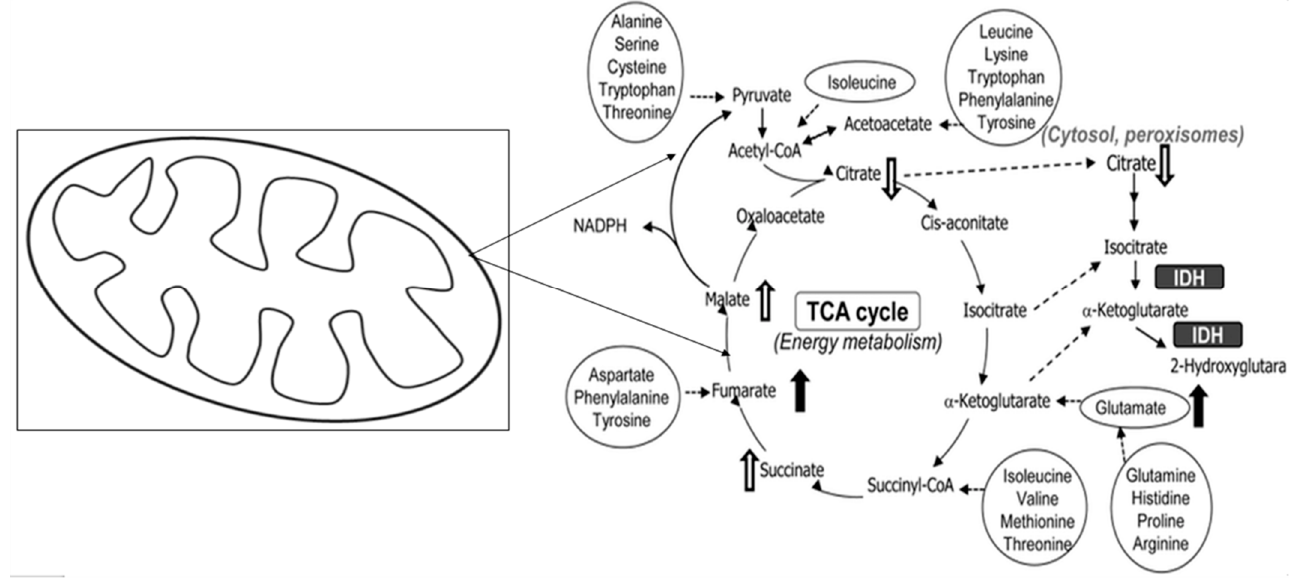
Figure 11. Schematic representation of the metabolomic pathway of amino acids taking place in mitochondria.